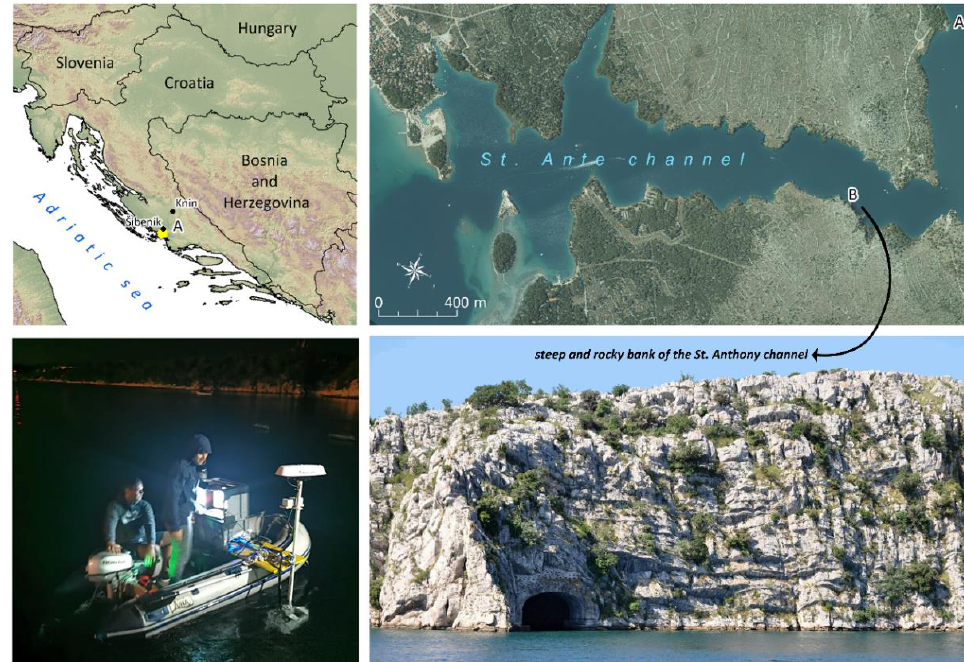
Figure 1. The geographic location of the St. Anthony Channel in Šibenik-Knin County (Croatia).